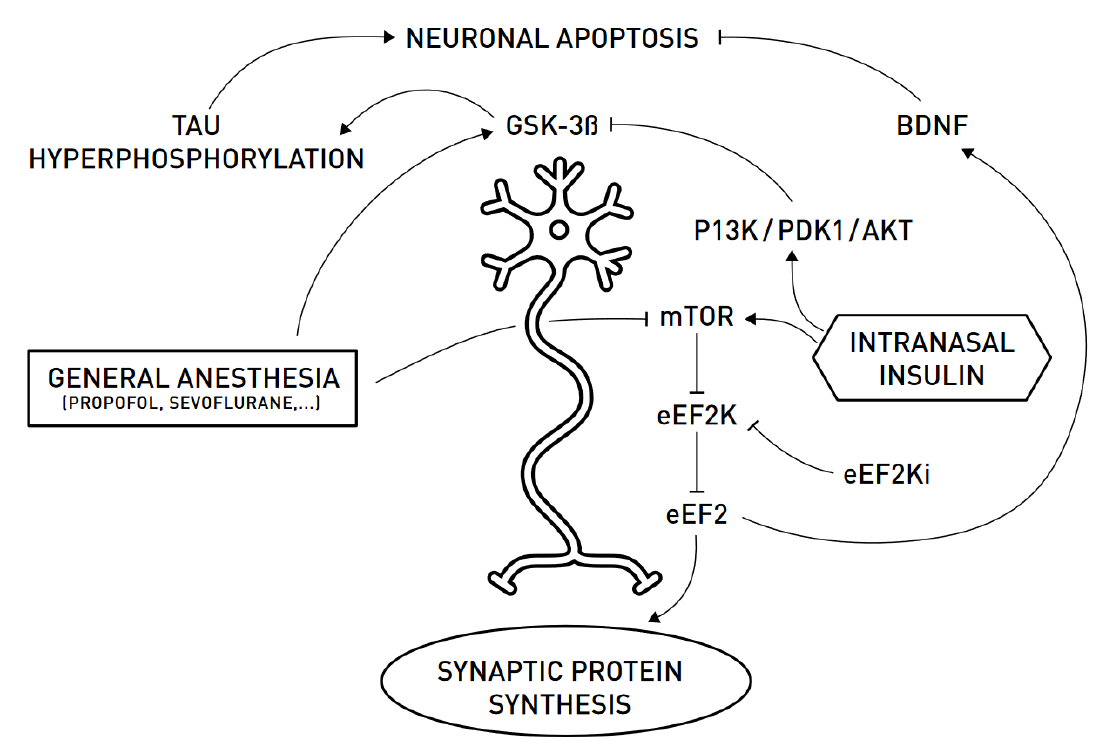
Figure 1. A schematic representation of the relationship between the neuron (in the center) and how insulin can possibly blunt anesthetic-induced apoptosis and tau phosphorylation. AKT, protein kinase B; BDNF, brain-derived neurotrophic factor; eEF2, eukaryotic elongation factor 2; eEF2K, eukaryotic elongation factor 2 kinase; eEF2Ki, eEF2K-inhibitor; GSK-3β, glycogen synthase kinase 3 beta; mTOR, mammalian target of rapamycin; PDK1, pyruvate dehydrogenase kinase 1; PI3K, phosphoinositide 3-kinase